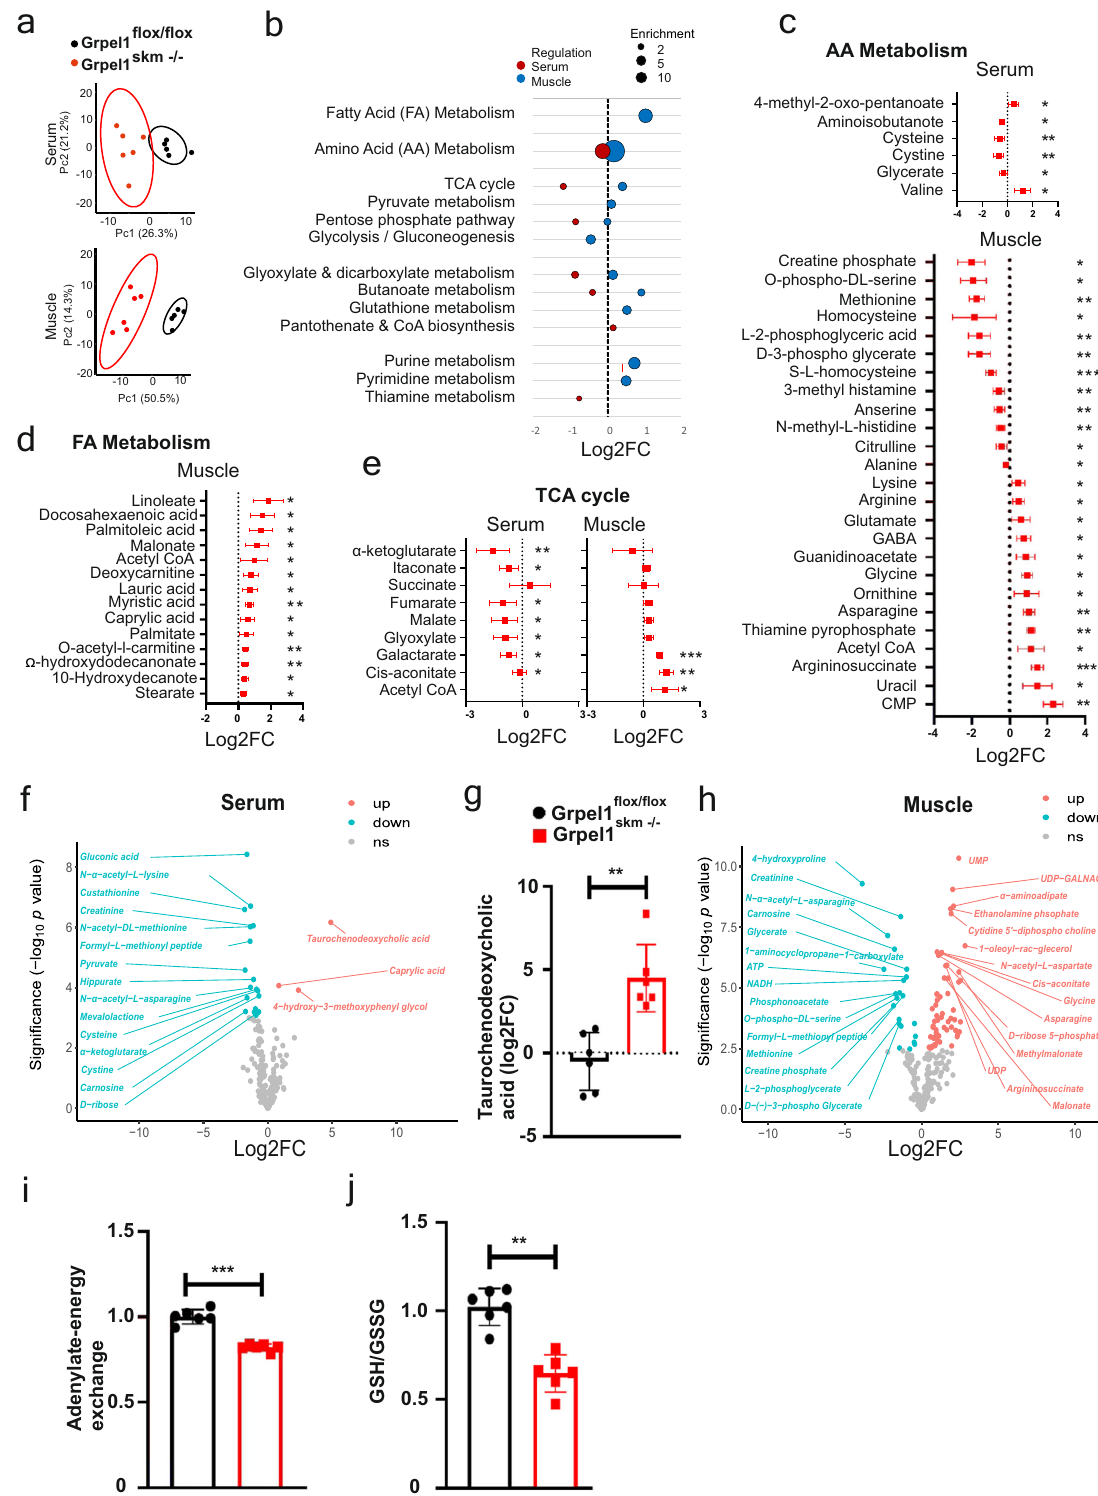
Cell signaling), rabbit anti-phospho-S6 ribosomal protein (Ser 240/244) (5364, Cell signaling), rabbit anti-LC3B (NB600-1384, Novus Biologicals), mouse anti-vinculin (V9264, Sigma) and mouse anti-p62 (2C11, Abnova). Membranes were washed and then incubated with respective HRP conjugated secondary antibodies for 1h in room temperature. The Clarity Western ECL Substrate (BioRad) was used to develop protein band signals, detected by Chemidoc XRS + Molecular Imager (Bio-Rad). Quanti fi cation was done with the ImageLab software